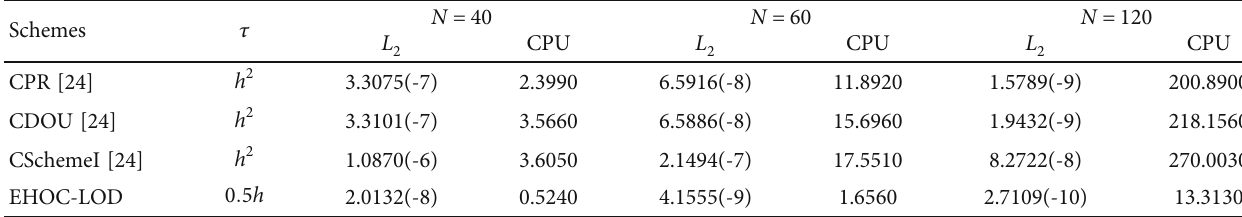
Table 4: The L norm error and CPU time at T = 2 for Example 2. 2